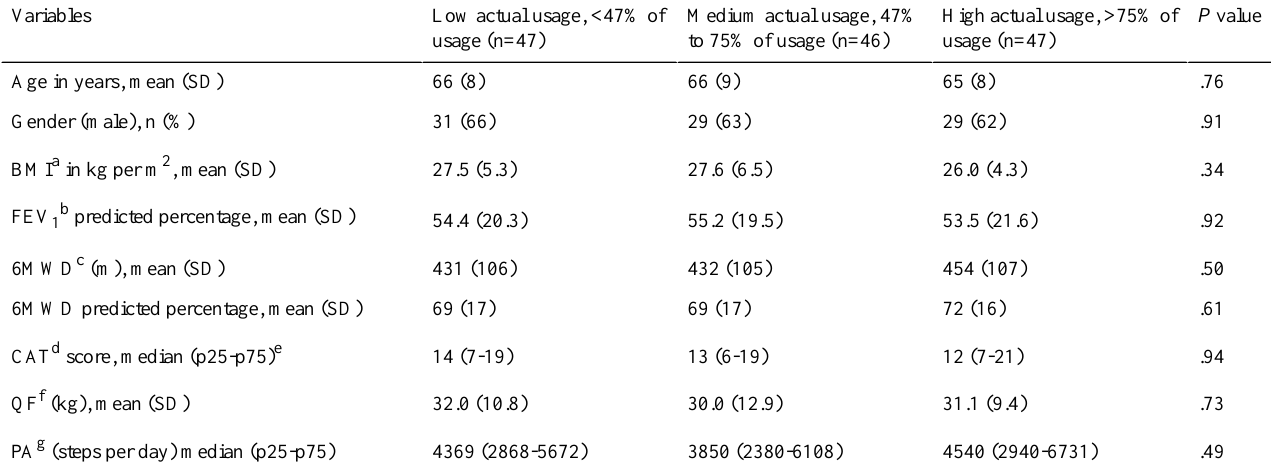
Table 4. Patient characteristics according to the total actual usage score (3 groups only including patients with valid physical activity measurement by actigraph, n=140); data are expressed as mean (SD) unless stated otherwise. P value indicates differences between the 3 actual usage groups.